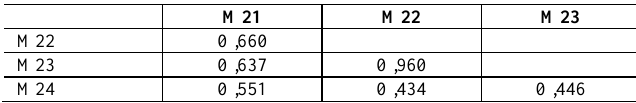
Table 6: Correlation coefficients for Measures (M)